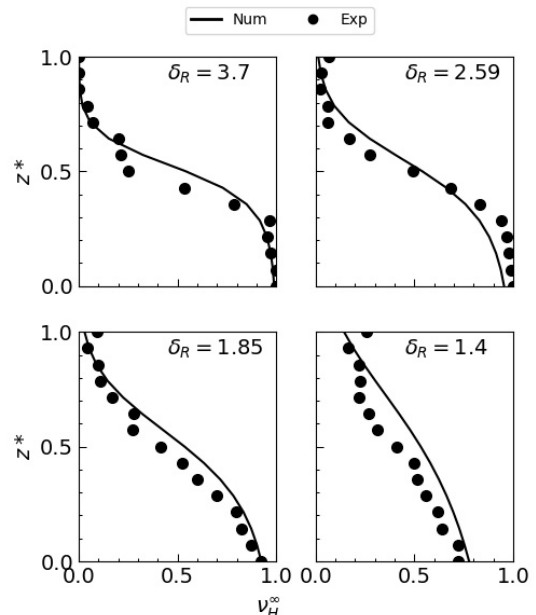
Fig. 4. The fully developed volume fraction profile for the four density ratios tested at steady state. The points have been obtained experimentally, whereas the solid lines represent the profile predicted by the model.